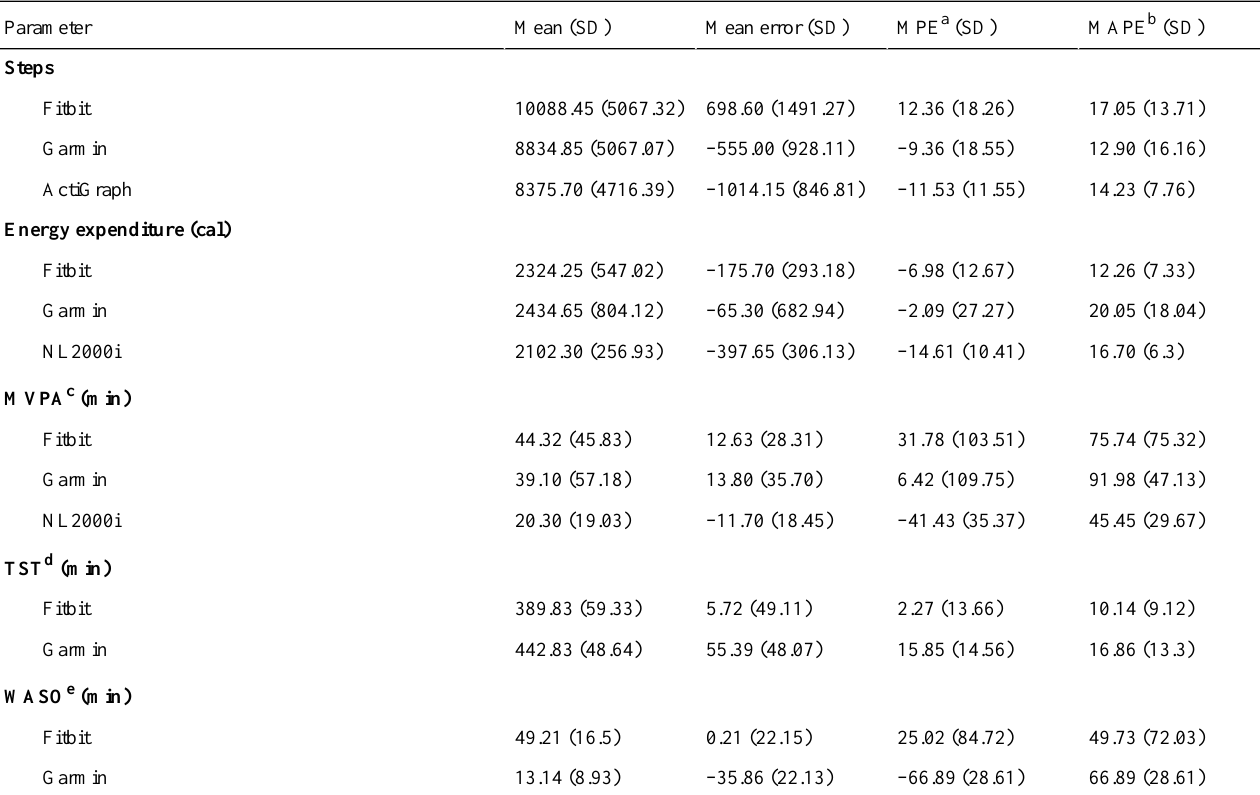
Table 2. Mean values measured, mean error, mean percentagage error, and mean absolute percentage error with related standard deviation for each parameter and tracker